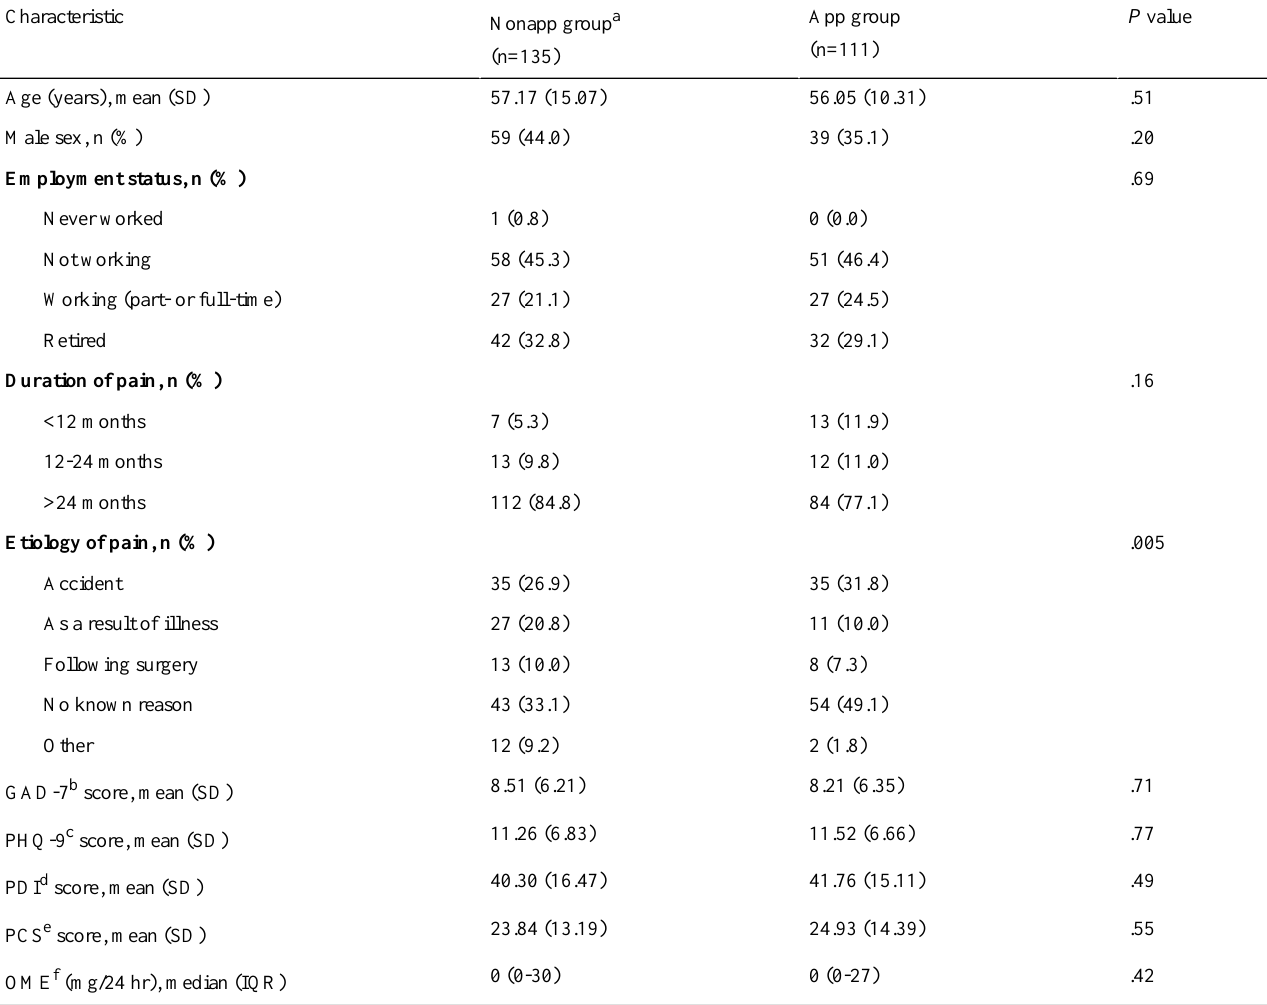
Table 1. Baseline demographics characteristics of the study